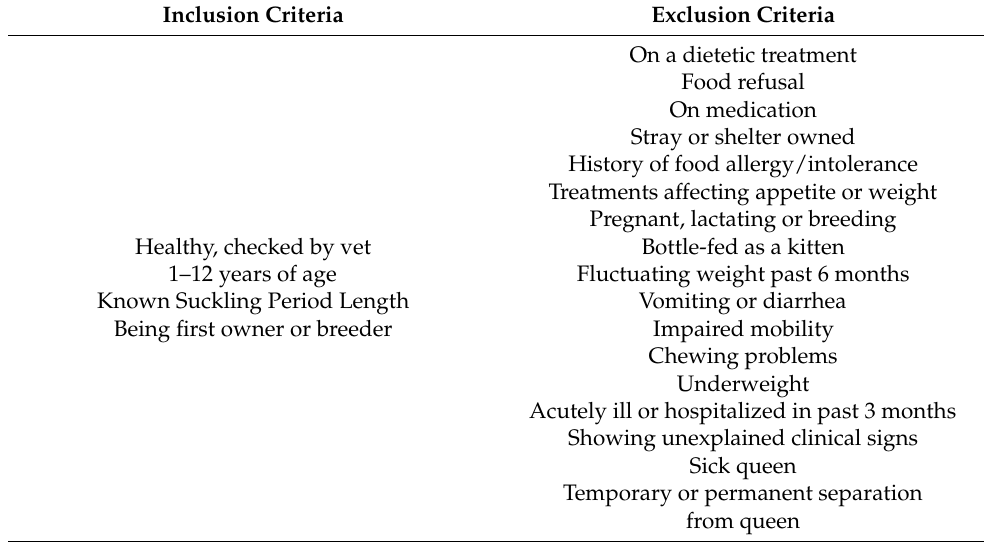
Table 1. Inclusion and exclusion criteria for the study